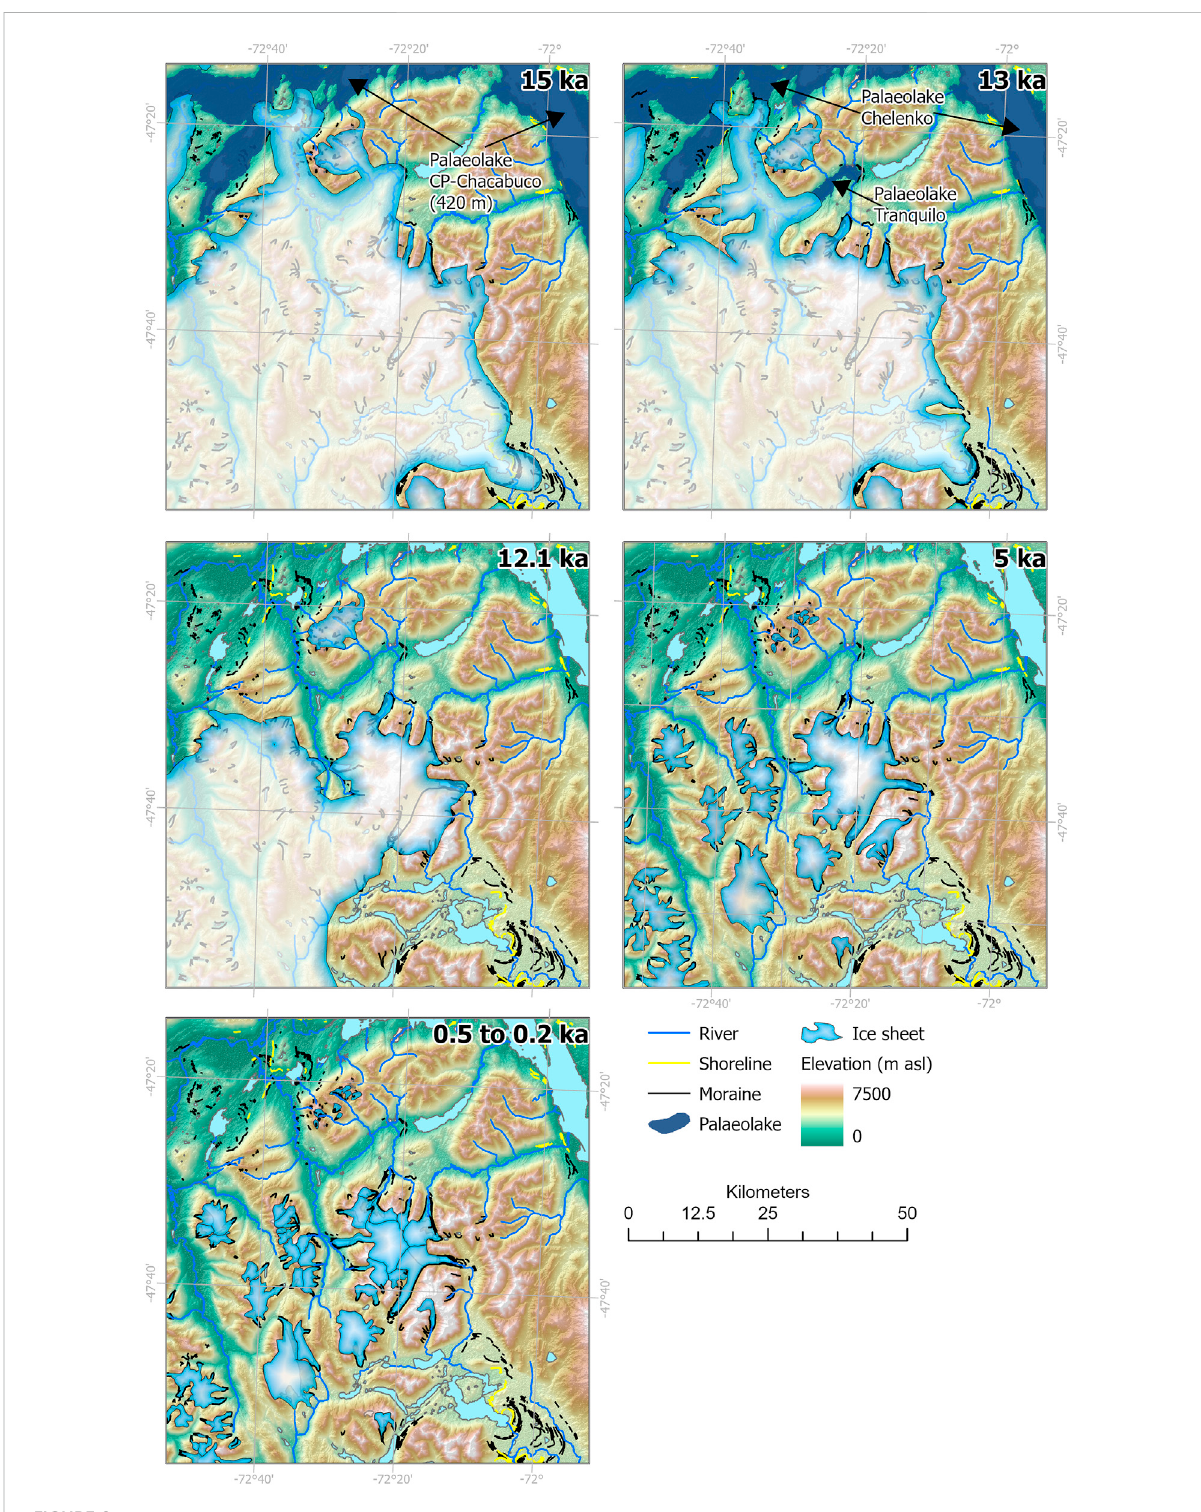
FIGURE 2 Empirical reconstruction of Monte San Lorenzo ice cap through the ACR (14.5 – 12.8 ka) Holocene, after numerous publications (Sagredo et al., 2016; 2018; Davies et al., 2018; 2020; Martin et al., 2019; 2022; Thorndycraft et al., 2019; Mendelová et al.,